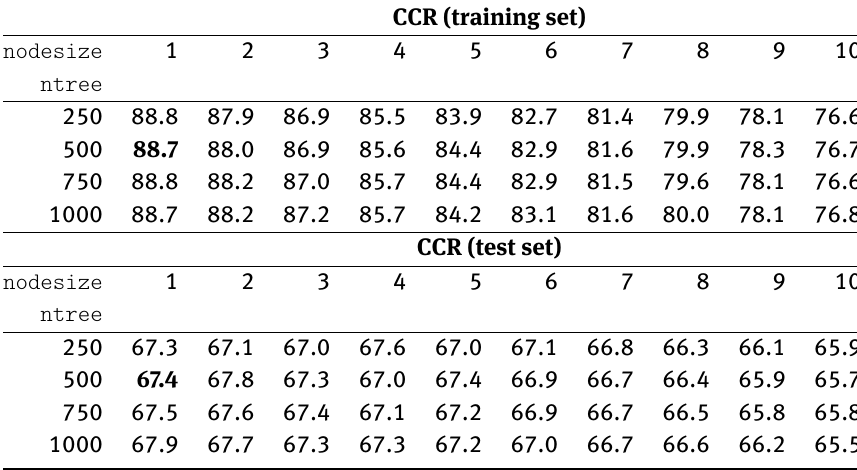
Table 5: Correct Classification Rate (CCR) obtained with Random Forest for several values of nodesize and ntree on the verbal Table 4. The training set includes τ = 63% individuals from the initial dataset.